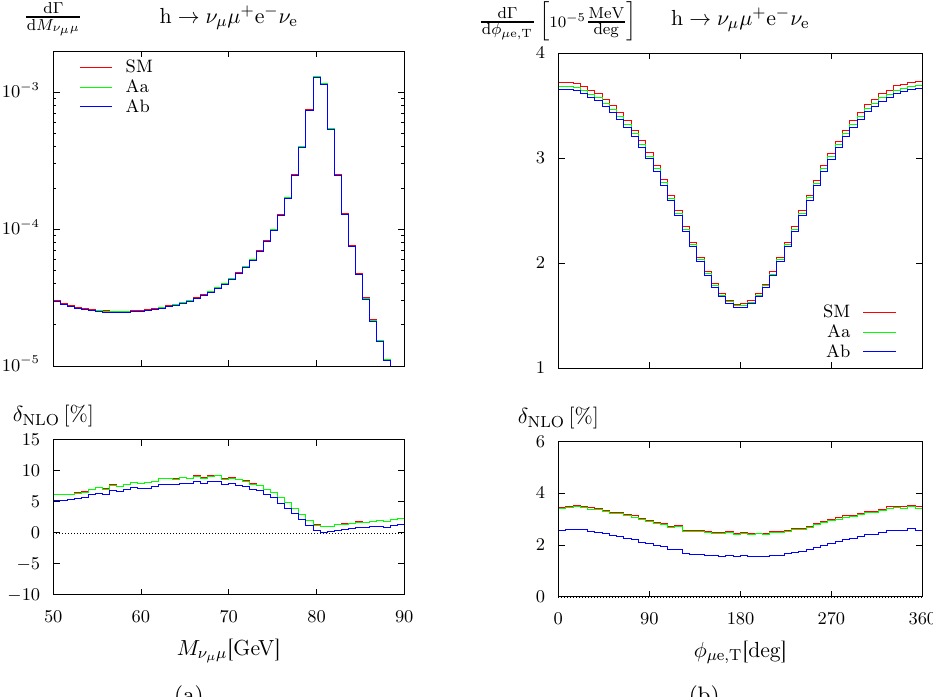
Figure 18 . As in (cid:12)gure 17, but for the leptonic charged-current decay h (cid:23) (cid:22) (cid:22) + e (cid:0) (cid:22) (cid:23) e . ! (cid:12)gure 17(a) for the SM and the THDM in scenarios Aa and Ab and show the Z-boson resonance. The relative corrections normalized to the LO are illustrated in the second panel and exhibit the well-known e(cid:11)ects of (cid:12)nal-state radiation near the Z resonance: photons radiated o(cid:11) a (cid:12)nal-state lepton lower the invariant mass of the lepton pair and lead to positive corrections | the \radiative tail" | for invariant masses below the Z-boson peak and negative corrections above. These corrections would contain a logarithm of the form (cid:11) ln( m (cid:22) =M h ) from collinear photon emission o(cid:11) muons if no photon